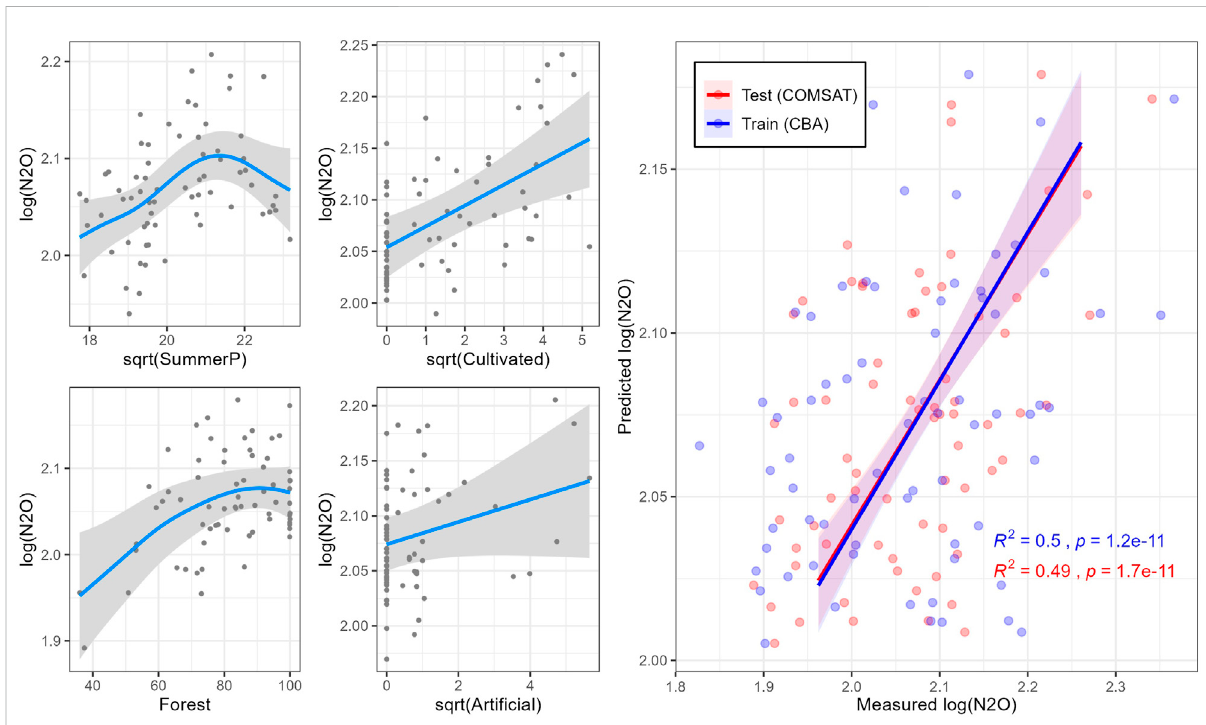
FIGURE 6 Simulations (blue lines) of normalized relative N 2 O saturations in the CBA dataset by generalized additive model (GAM) 3. On the right side, model training with CBA dataset (red) and test with COMSAT dataset (blue) for each model. Shaded gray areas indicate 95% con fi dence